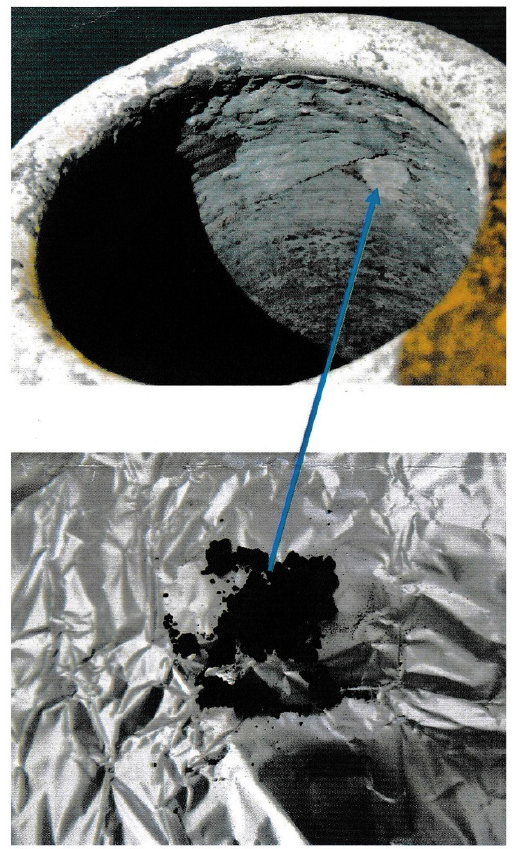
Figure 8. Sampling site and sample of the torpedo jar (© National Museum, Sultanate of Oman).